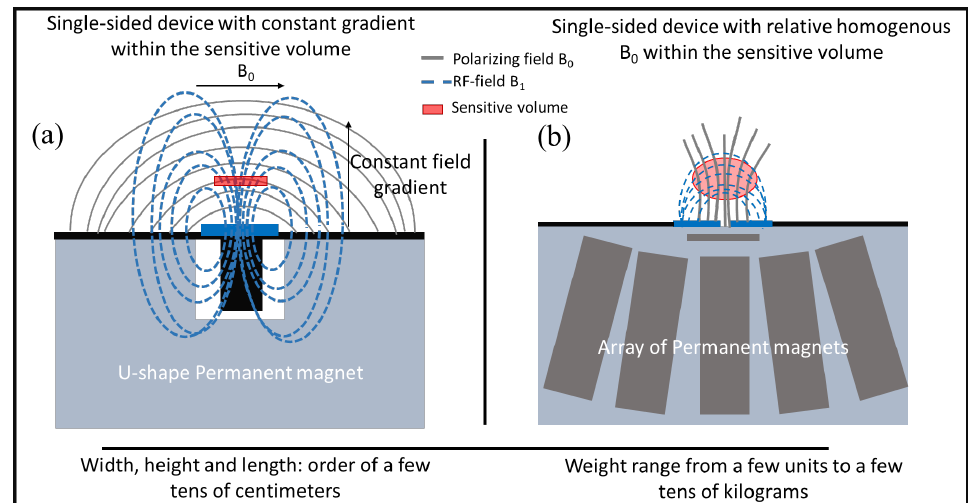
Figure 3. ( a ) Sketch of the design of a single-sided NMR device with a constant field gradient within the sensitive volume; ( b ) sketch of the design of a single-sided NMR device with a relative homogeneous B 0 within the sensitive